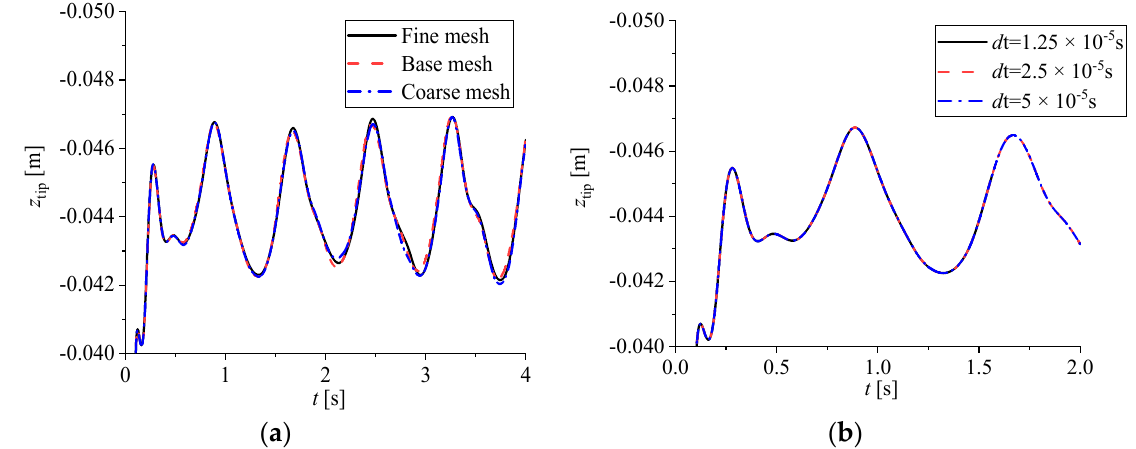
Figure 4. Time histories of the tip displacement with different ( a ) mesh densities and ( b ) time steps for a case of d = 0.18 m, H = 0.1 m, and T = 0.8 s.